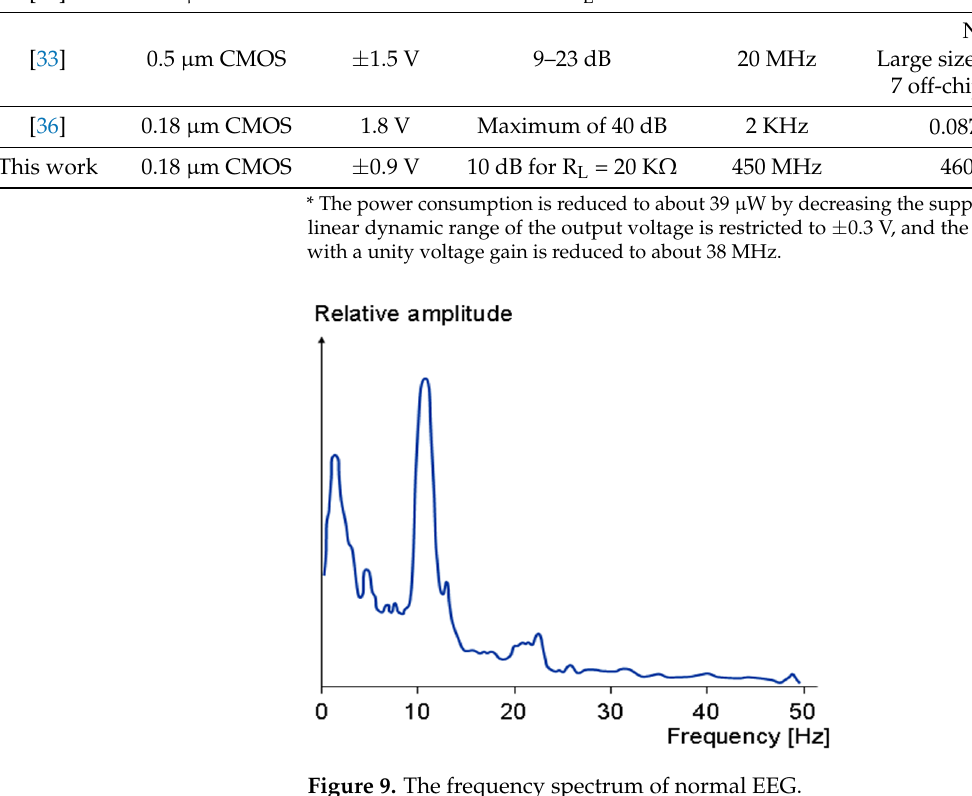
Figure 9. The frequency spectrum of normal EEG.